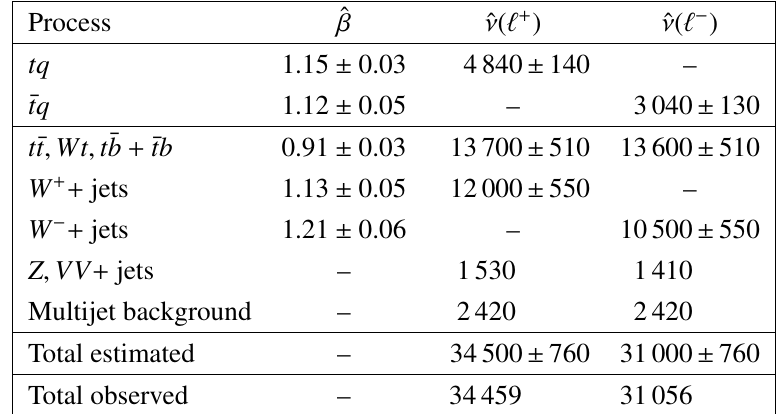
Table 3 . Estimated scale factors, ˆ (cid:12) , and number of events, ˆ (cid:23) = ˆ (cid:12) (cid:1) (cid:23) , for the ‘ + and ‘ (cid:0) channel from the minimisation of the likelihood function. The quoted uncertainties in ˆ (cid:12) and ˆ (cid:23) include the statistical uncertainty and the uncertainties from the constraints on the background normalisation as used in the likelihood function.